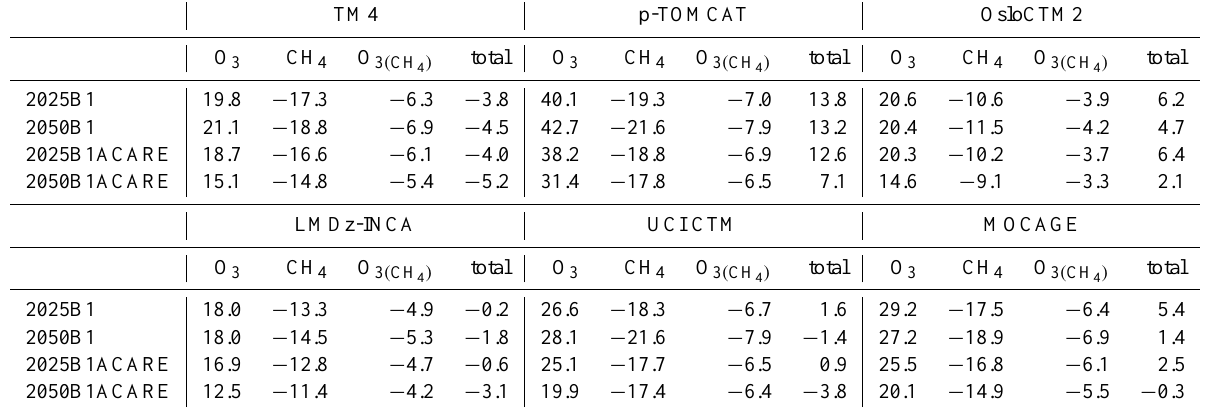
Table B3. Radiative forcings (mWm − 2 ) from changes in ozone, methane (including stratospheric water vapour), and methane-induced ozone for different years/scenarios, due to emissions from aircraft. Note that the history of emissions has been taken into account, and that the fully scaled perturbations were